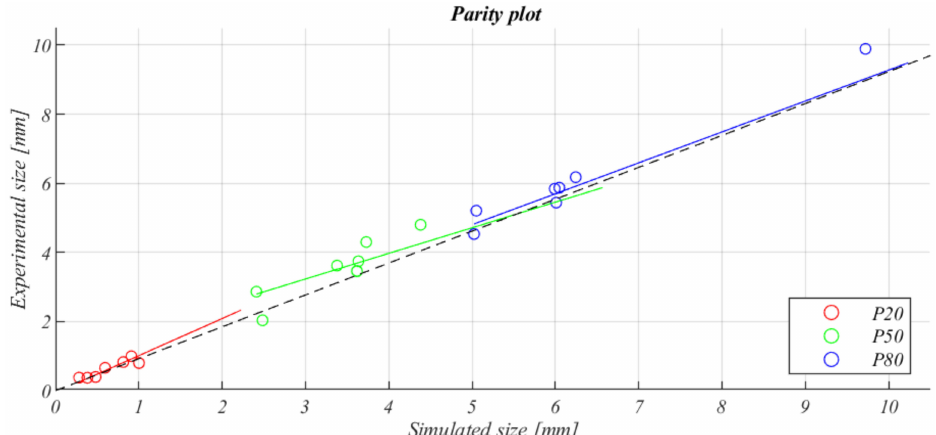
Figure 8. A parity plot of the P20, P50 and P80 values from the experimental data compared to the simulated data using the developed models.